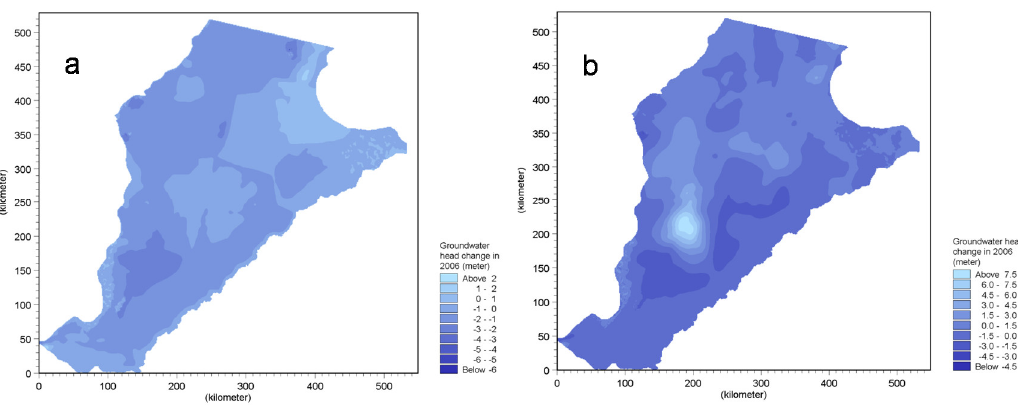
Figure 11. Spatial distribution of groundwater head change in 2006 ( a ) using precipitation data based on rain gauge data; ( b ) calculated based on remote sensing data.